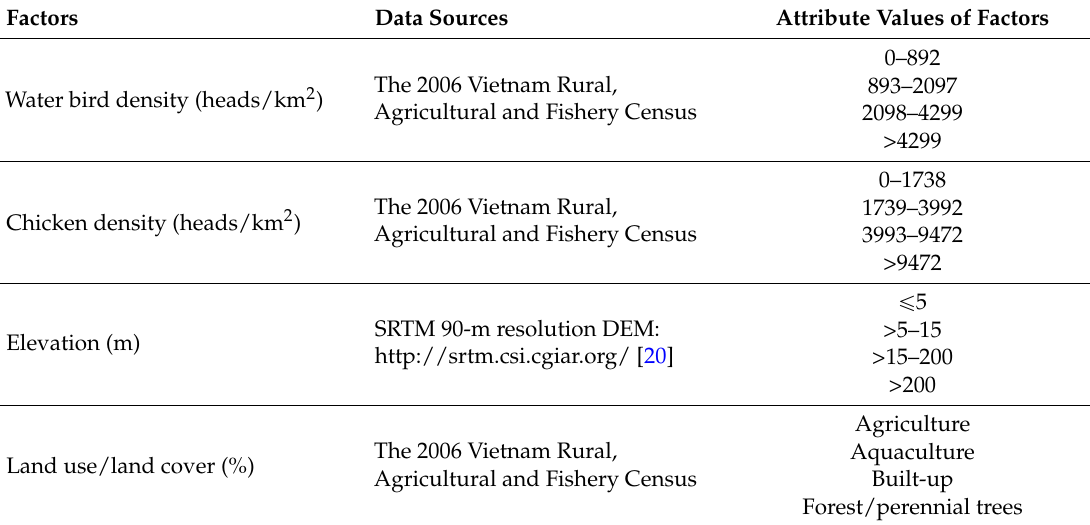
Table 1. Critical factors affecting the disease